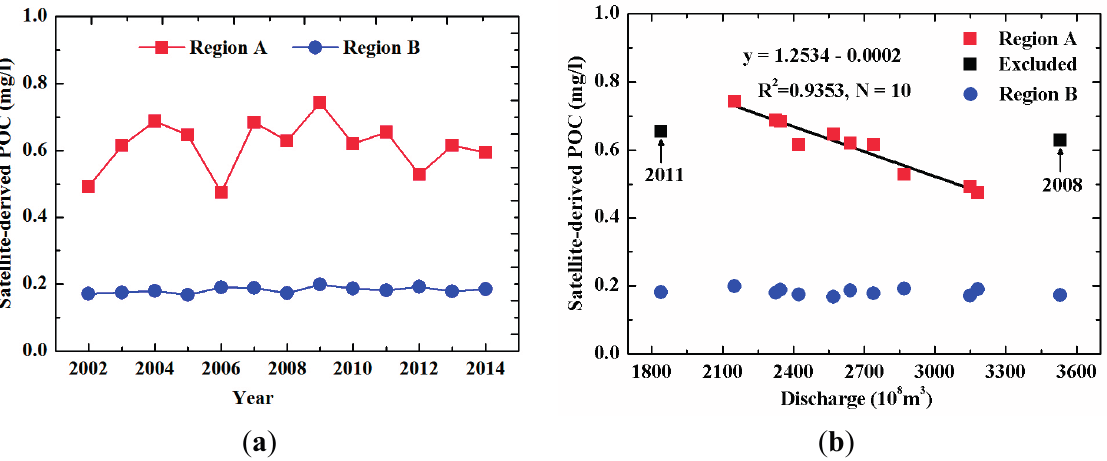
Figure 7. Annual satellite-derived POC in the PRE in different years: ( a ) Annual POC concentrations in region A and B, which are defined in Figure 1; ( b ) relationship between annual POC in the PRE and discharge of the Pearl River. Pearl River discharge was calculated from the daily discharge of three control hydrometric stations, Boluo, Shijiao, and